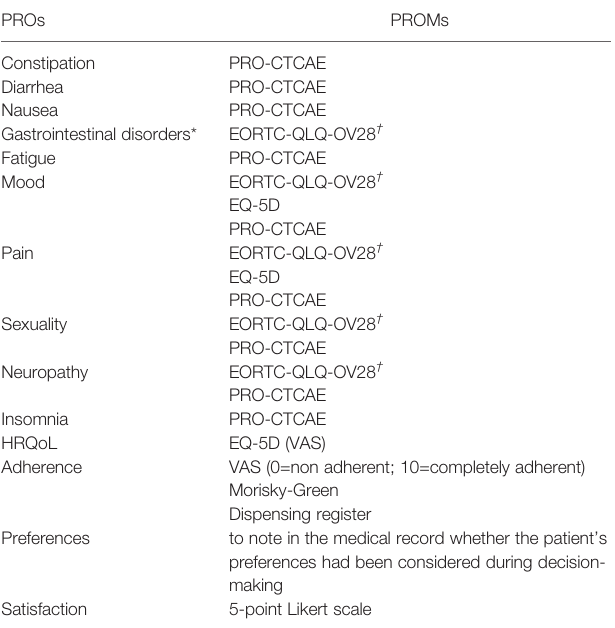
TABLE 1 | PROs and PROMs agreed upon by the nominal group, presented in the Delphi